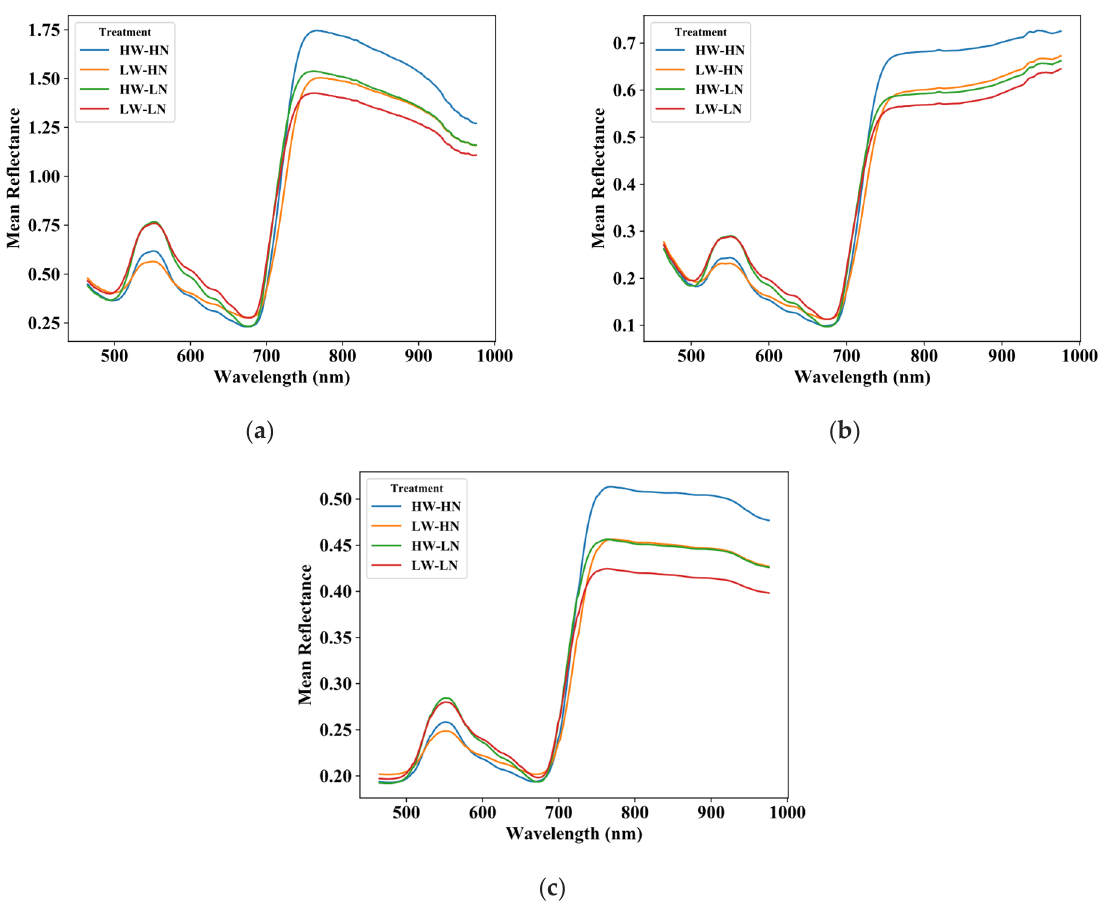
Figure 2. Mean reflectance profiles of the different treatments: ( a ) plants imaged in facility 1 with 6 ms exposure, ( b ) plants imaged in facility 1 with 3 ms exposure, and ( c ) plants imaged in facility